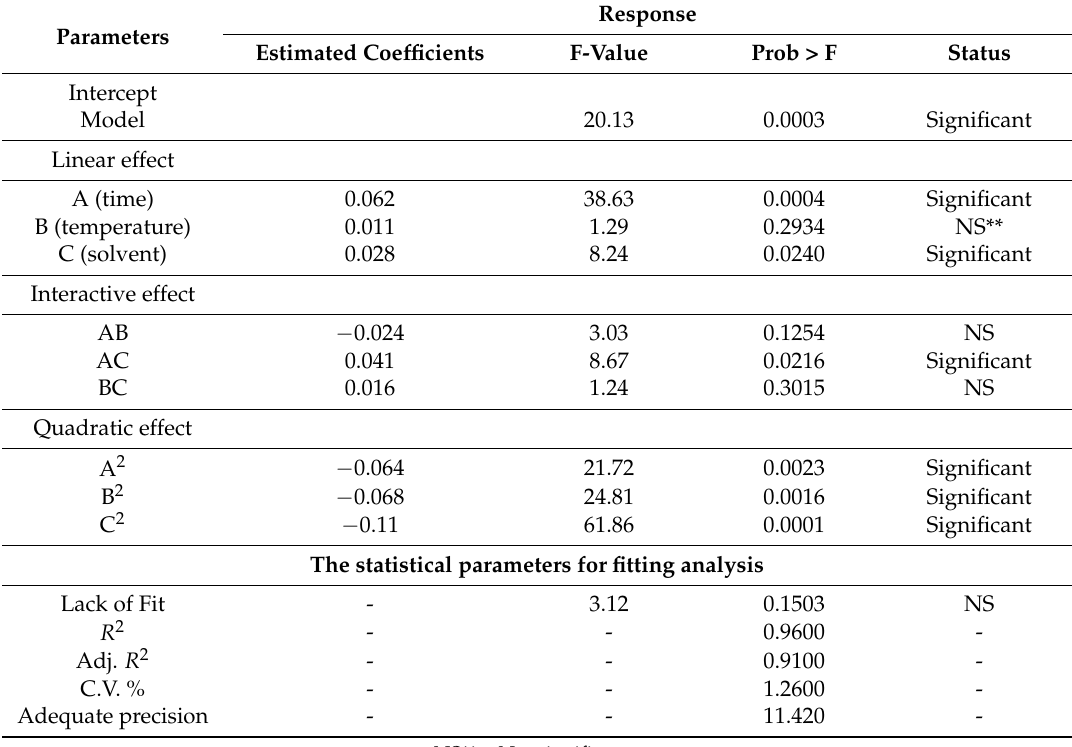
Table 3. The analysis of variance (ANOVA) of independent-variables influence on DHM yields using the developed quadratic surface response model and testing the significance of obtained regression